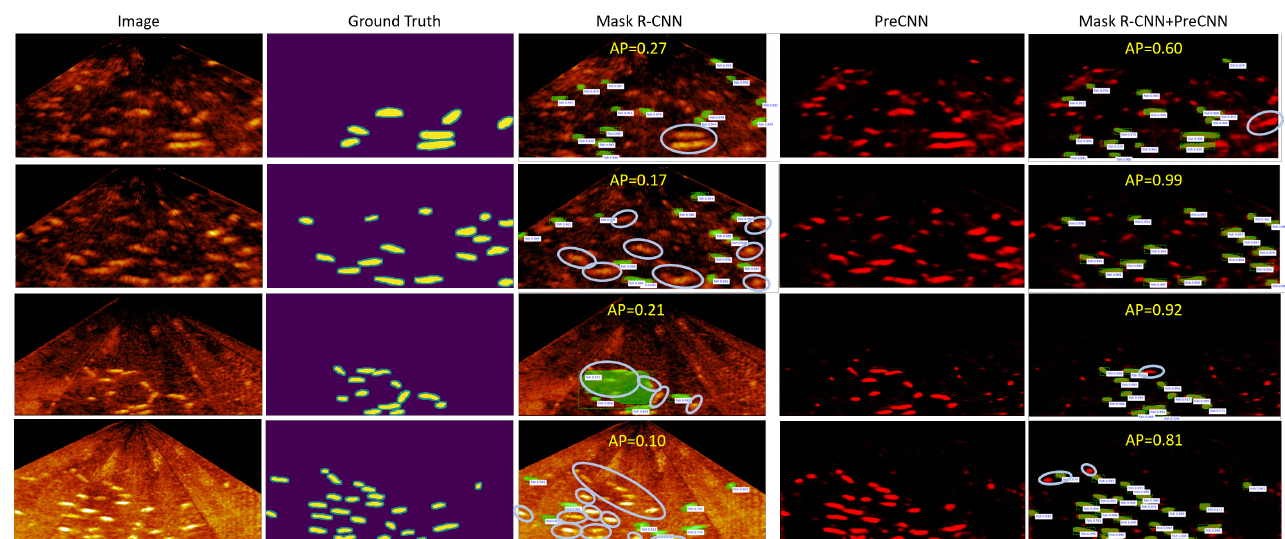
Figure 7. Examples of applying Mask R-CNN and Mask R-CNN+PreCNN across different environments, where a fish in the ground truth and not detected is enclosed by a circle; the threshold of the confidence score for Mask R-CNN is 0.2; the first two rows show applying the model for E-A to E-C and applying the model for E-B to E-C, respectively, and the last two rows show applying the model for E-C to E-A and to E-B, respectively.